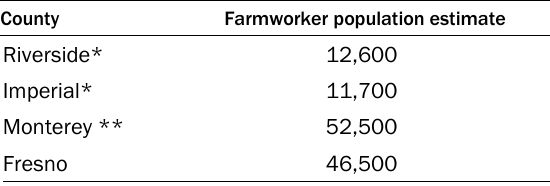
Table 1. Farm Labor Workforce Estimates in